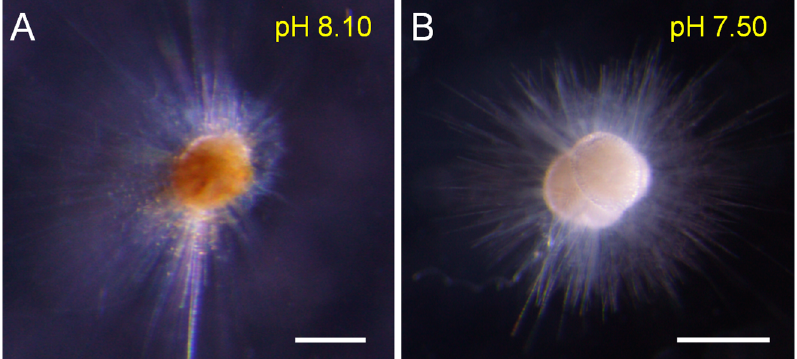
Figure 2. The color comparison between different individuals under different pH conditions shows the bleaching phenomenon under low-pH conditions ( A : the normal individual; B: the bleached individual). Scale bar = 200 µ m.